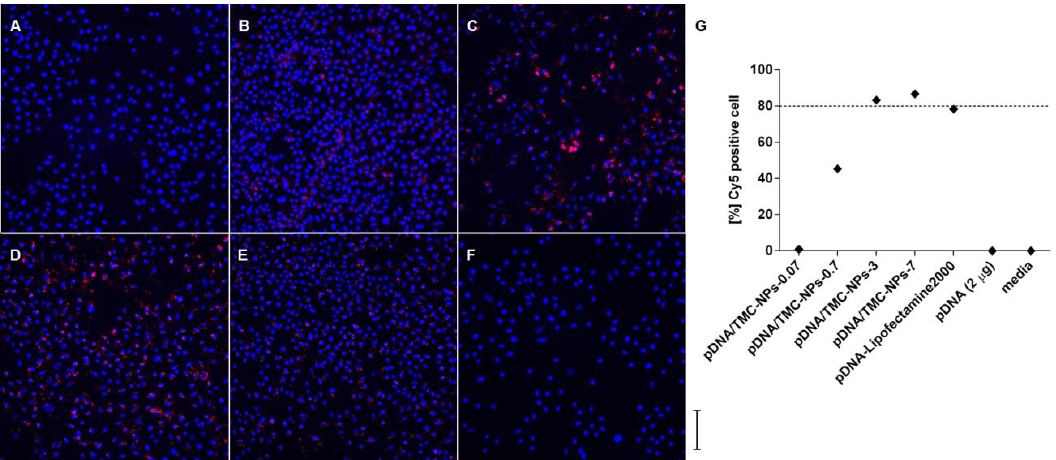
Figure 2. ( A – F ) Cellular uptake of Cy5-labeled pDNA (red) around nuclei (blue); ( G ) pDNA uptake was calculated for each well by calculating Cy5-positive cells (red) in relation to the number of nuclei (DAPI stained area; blue); representative wide field high content microscopy images of A549 cells, incubated for 2 h with formulations of pDNA-Cy5/TMC-NPs-0.07 (1% uptake; (A)); pDNA-Cy5/TMC-NPs-0.7 (45% uptake; (B)); pDNA-Cy5/TMC-NPs-3 (83% uptake; (C)); pDNA-Cy5/TMC-NPs-7 (87% uptake; (D)); pDNA-Cy5-Lipofectamine2000 (78% uptake; (E)); and pDNA-Cy5 alone (0% uptake; (F)). Images